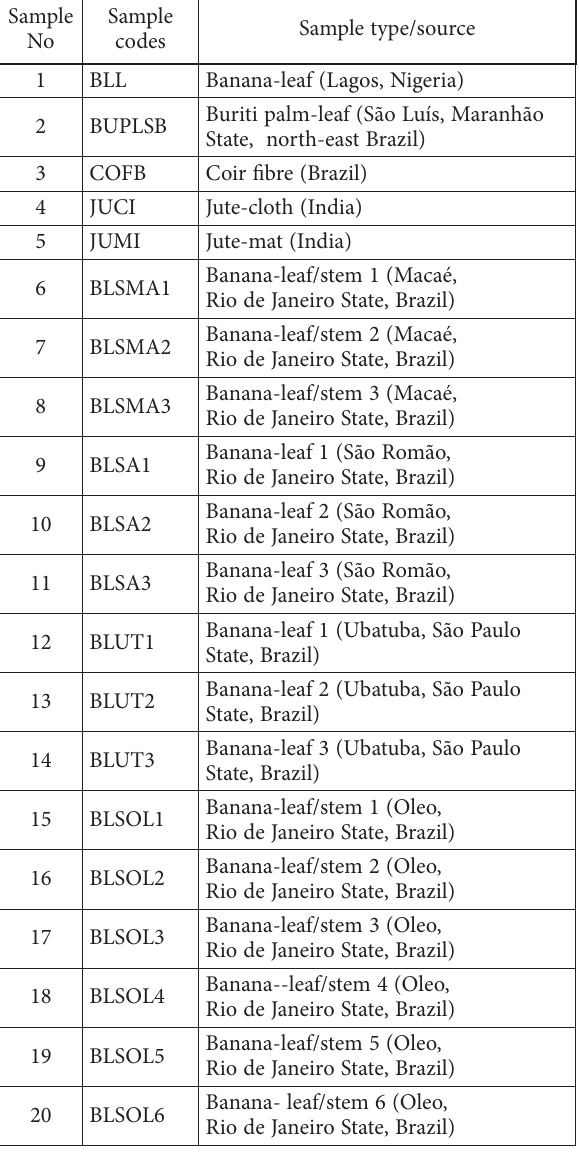
Table 1. Sample locations and description of the study